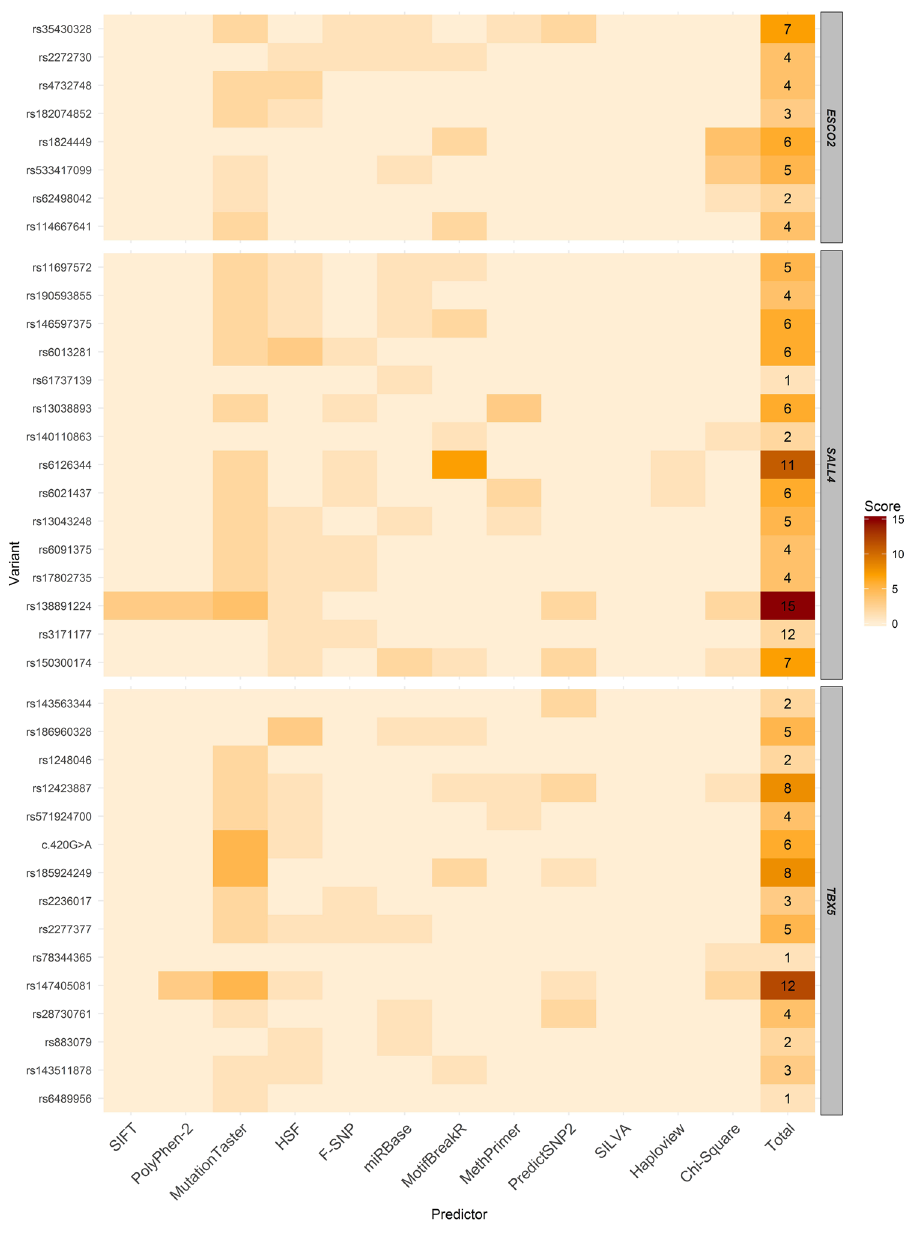
Figure 2. Heatmap representing the potential impact of variants found in ESCO2 , SALL4 and TBX5 genes in regulatory features of these genes, their proteins and in TE. In the lines are represented the variants, the scores assigned to them after functional predictions and the final score. The scores are presented by color tone variation; the higher the points the darker the color; the lower the points the lighter the color. Regarding the columns, the first ten represent variant effect prediction tools, the eleventh represents the formation of haplotypic blocks and the twelfth represents the statistically significant difference of some variant with the genomic databases. The variant effect prediction tools pointed out variants which altered the features evaluated by the tool, being the impact of lesser or greater degree. To haplotypic blocks, it received a point variants that formed block. Variants with a statistically significant difference of allelic frequencies between the TE sample and the databases were pointed out, being greater the score of variants which differed from more than one